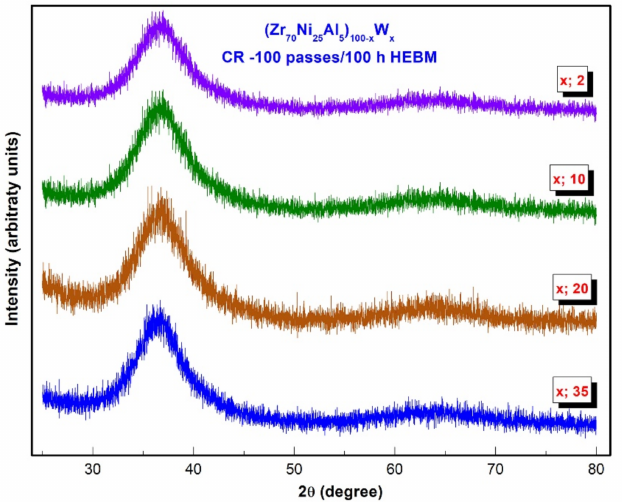
Figure 7. XRD patterns of (Zr 75 Ni 25 Al 5 ) 100-x W x (x; 2, 10, 20, and 35 at. %) powders obtained after 100 passes of CR and then milled for 100